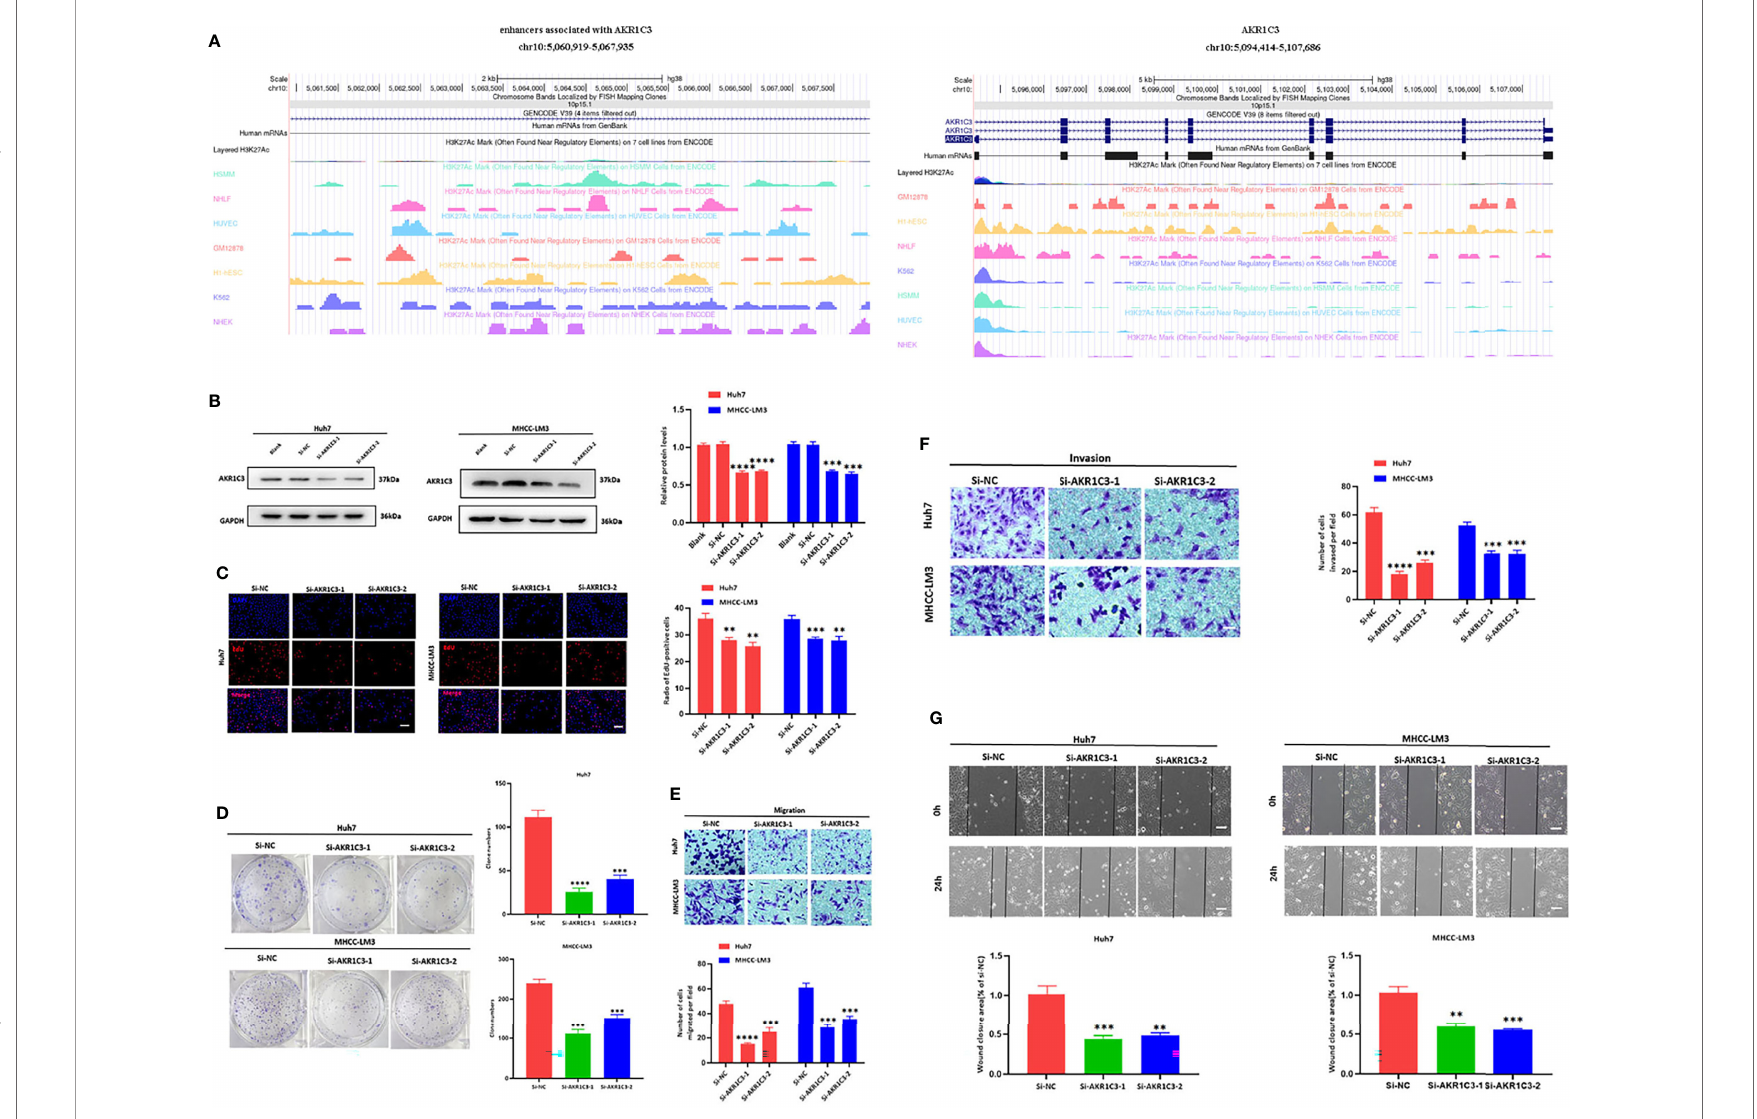
FIGURE 9 | (A) The locations of AKR1C3 and enhancers associated with AKR1C3 on chromosome. (B) Western blot analysis to examine the ef fi ciency of the AKR1C3 knockdown. (C) Proliferation ability in AKR1C3 knockdown Huh7 and MHCC-LM3 cells by EdU staining. (D) Colony-forming abilities in AKR1C3 knockdown Huh7 and MHCC-LM3 cells by clonogenic assays. (E, F) Transwell assays to detect the migration and invasive capacities in AKR1C3 knockdown Huh7 and MHCC-LM3 cells. (G) Wound-healing assay was performed to measure the migration ability of various cells as indicated. Magni fi cation, × 200 (C, E, F) , × 40 (G) . Scale bar, 100 mm (C, E, F) , 500 mm (G) . Data were shown as mean ± SD of at least three independent experiments. (**p < 0.01; ***p < 0.001; ****p <